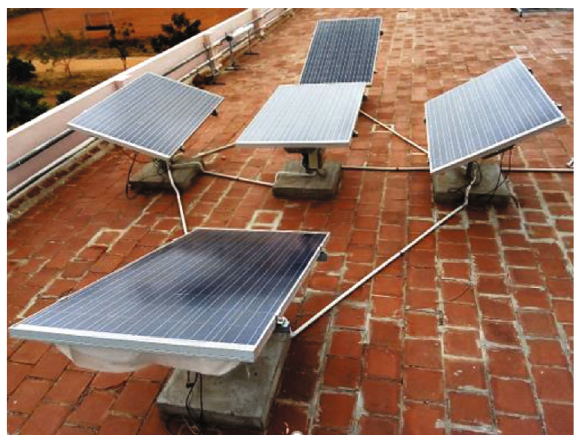
Figure 1: BISTPV solar photovoltaic power plant [26].